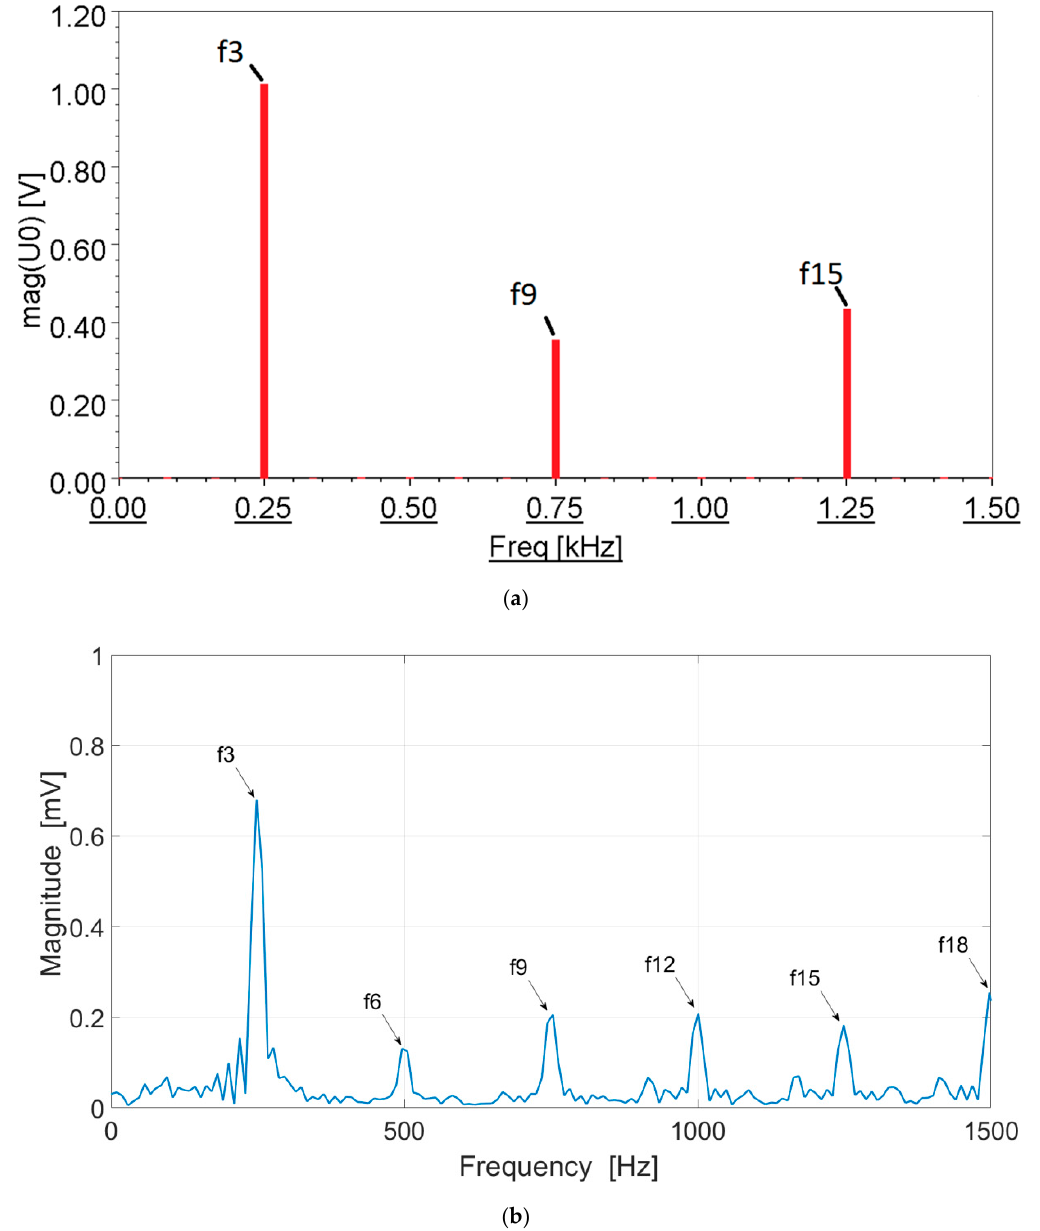
Figure15. Delta( ∆ )configuration—FFTofneutralvoltage u 0 inhealthymode:( a )numericalcalculations; Figure 15. Delta ( Δ ) configuration—FFT of neutral voltage u 0 in healthy mode: ( a ) numerical ( b ) calculations; ( b ) measurements.